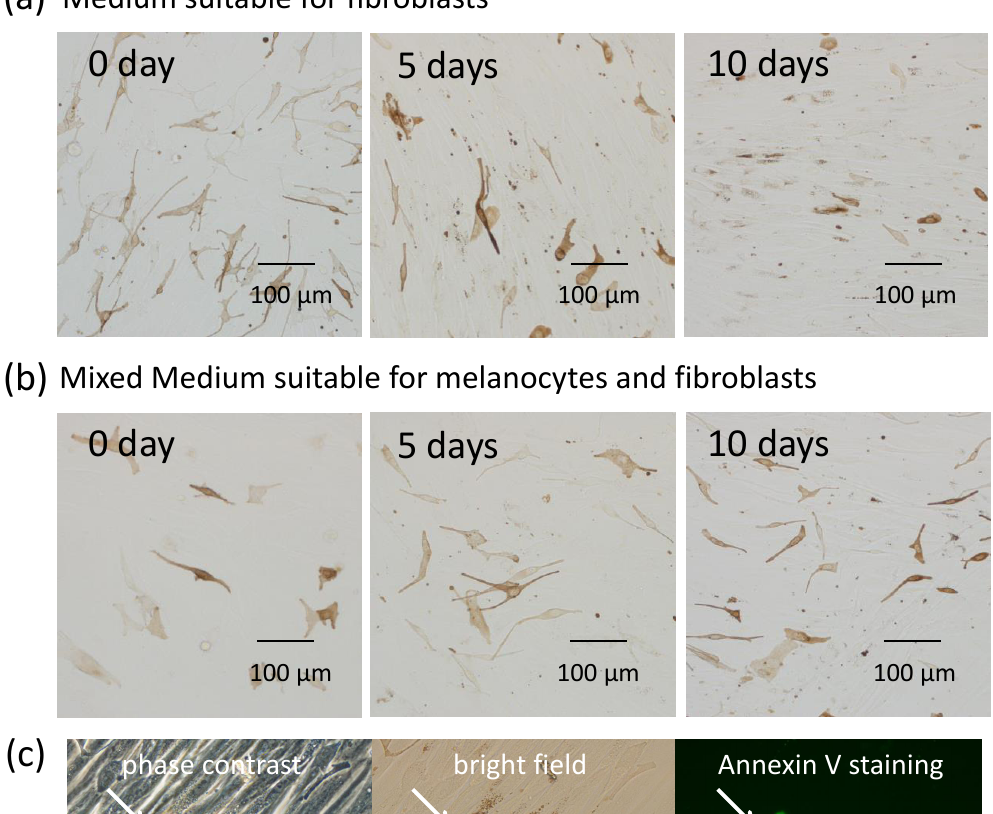
Fig. 4-1 Medium suitable for fibroblasts